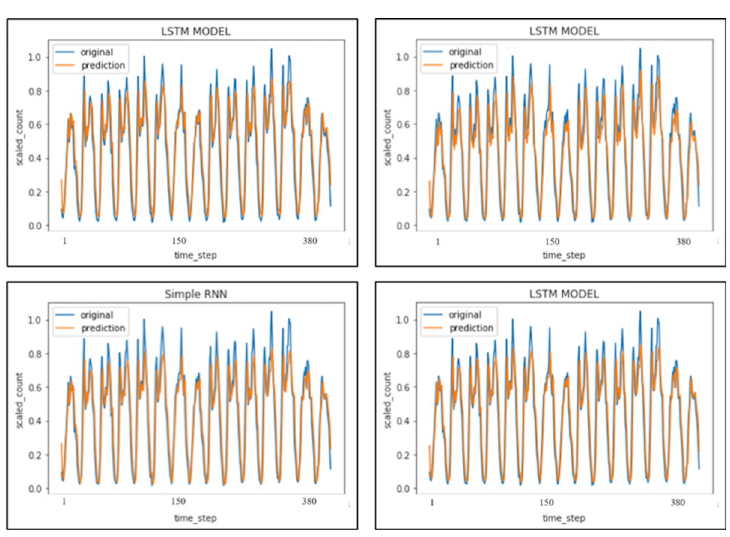
Fig 8. Top-left (LSTM with “relu” activation, 3 layers and 50 hidden nodes). Top-right (LSTM with “tanh” activation, 3 layers and 50 hidden nodes). Bottom-left (Simple RNN) Bottom-right (LSTM with “relu” activation, 3 layers with 20 hidden nodes).